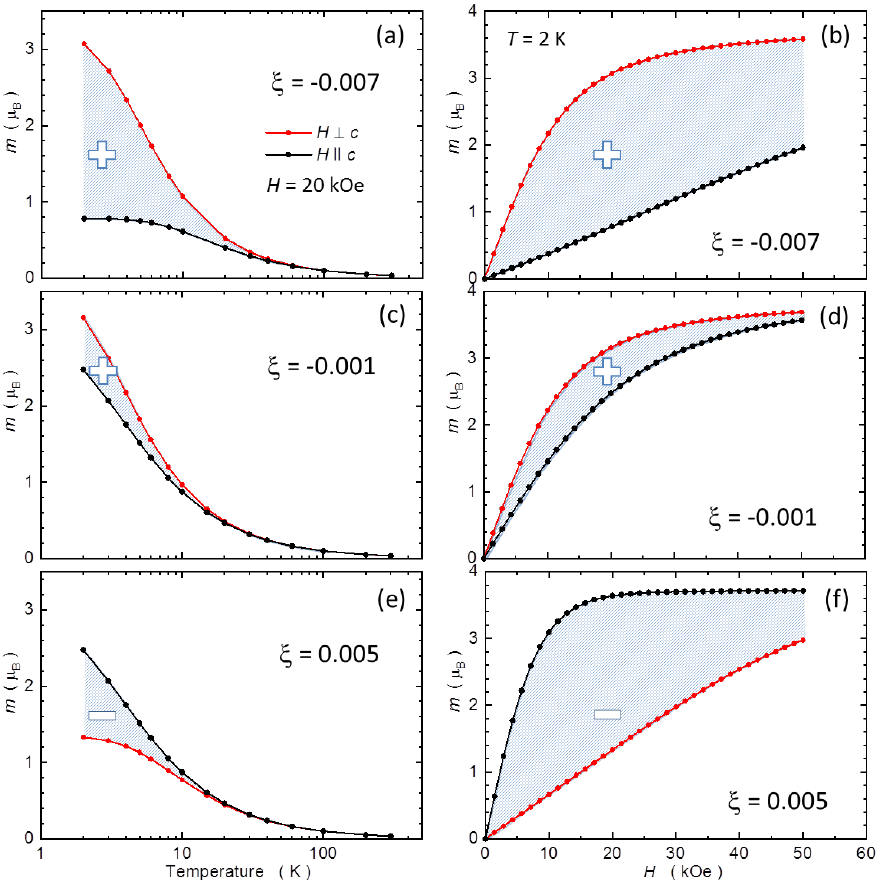
Figure 3. Single-ion magnetic anisotropy for Mn 3+ ion in GaN calculated as a function of temperature T at H = 20 kOe [left panels ( a , c , e )], and as a function of magnetic field H at T = 2 K [right panels ( b , d , f )] for a model system of wurtzite GaN:Mn. The red symbols represent the H ⊥ c orientation, the black ones the H || c one, where c is the wurtzite hexagonal axis. The magnetic moment m is expressed in Bohr magnetons. We define the positive magnetic anisotropy when m ( H ⊥ c ) > m ( H || c ). The corresponding signs are indicated in each panel. The key model parameter here is the magnitude of ξ = c/a − (8/3) 1/2 , which quantifies the relative magnitude of the trigonal deformation from the ideal wurtzite structure